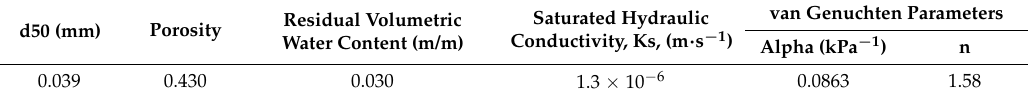
Table A1. Selected hydraulic properties of soil used to perform numerical simulations.